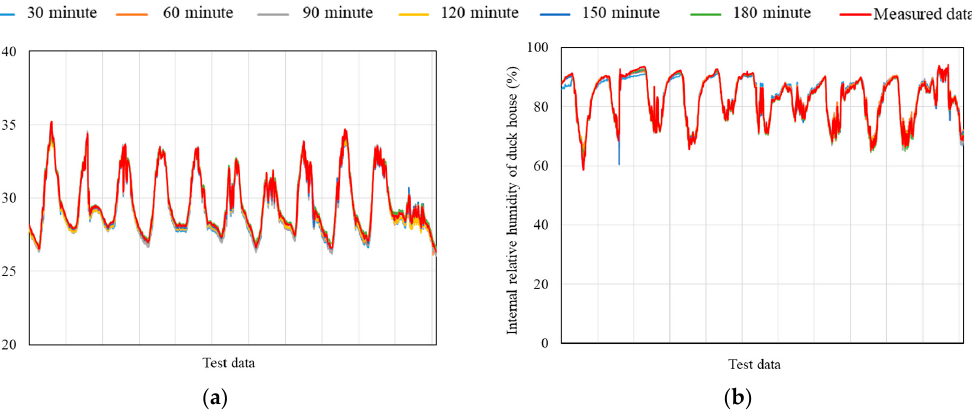
Figure 6. Test data measured during field experiment and predicted by RNN model according to sequence lengths (mechanically ventilated duck house, summer). ( a ) Air temperature